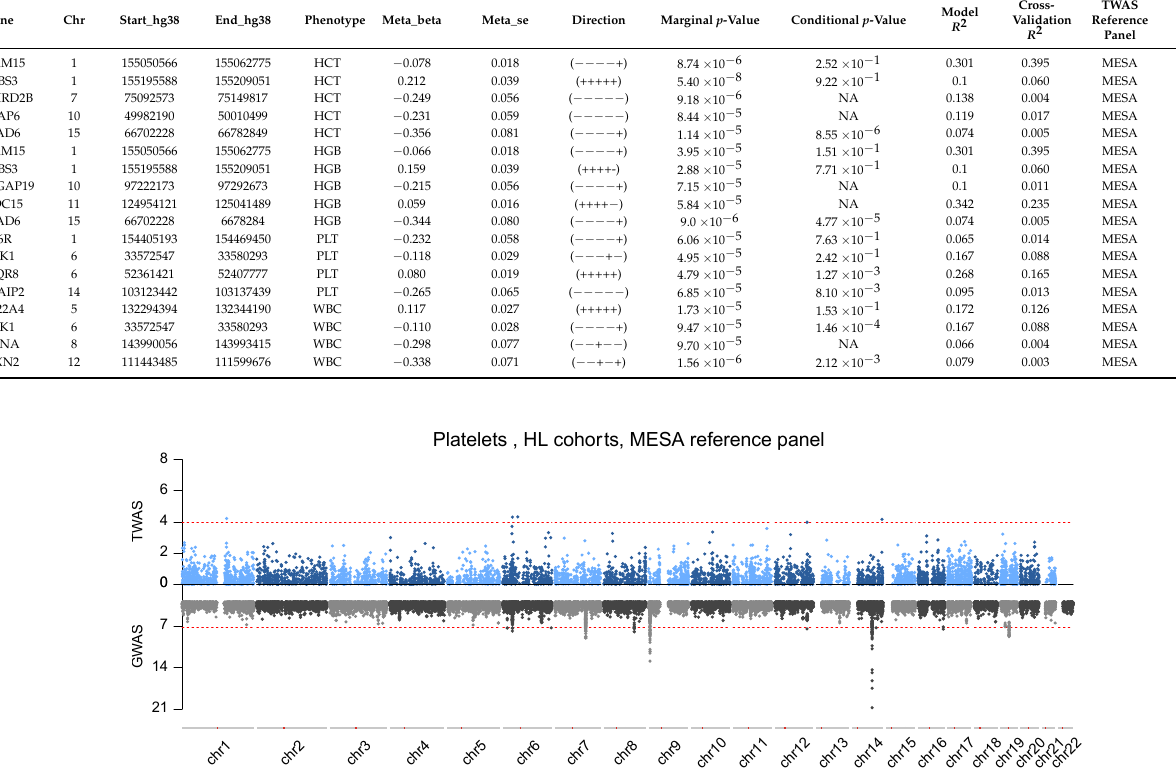
Figure 5. Mirror plot for the TWAS and GWAS results for platelets (PLT) in Multi-Ethnic Study of Atherosclerosis (MESA) Hispanic/Latino (HL). The upper panel shows TWAS marginal results and Table 1. 10 − 4 for TWAS and 5 × 10 − 8 for GWAS.